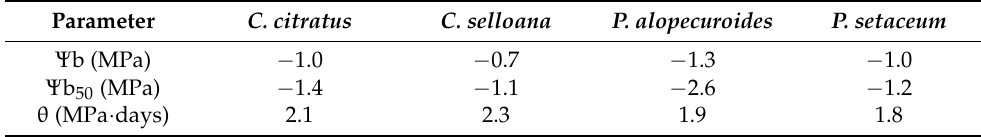
Table 1. Base osmotic potential for maximum germination ( Ψ b), base water potential for a 50% inhibition of the maximum germination ( Ψ b 50 ) and hydrotime ( θ ), measured for each studied species.